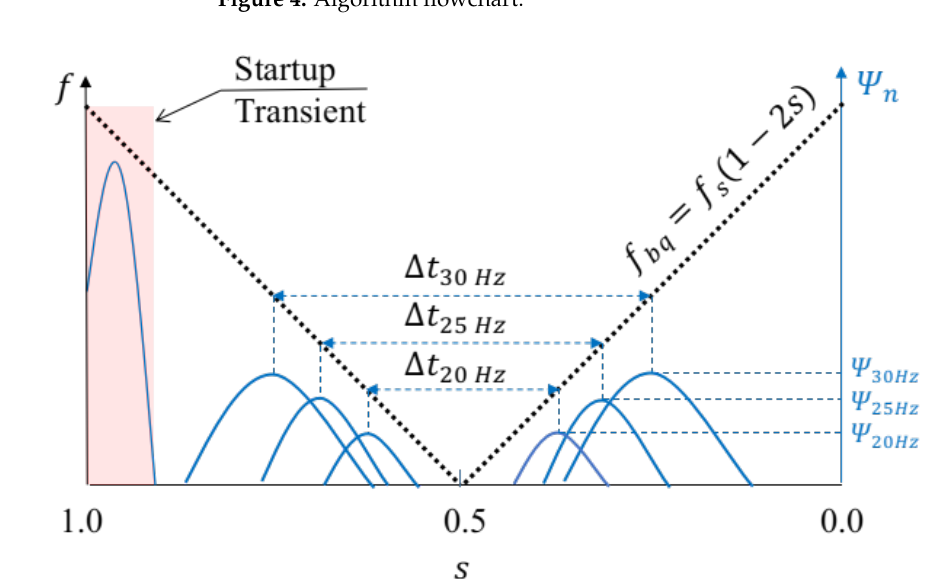
Figure 5. Broken Rotor bar’s failure frequency and Teager Energy filtered at different frequencies as a function of the